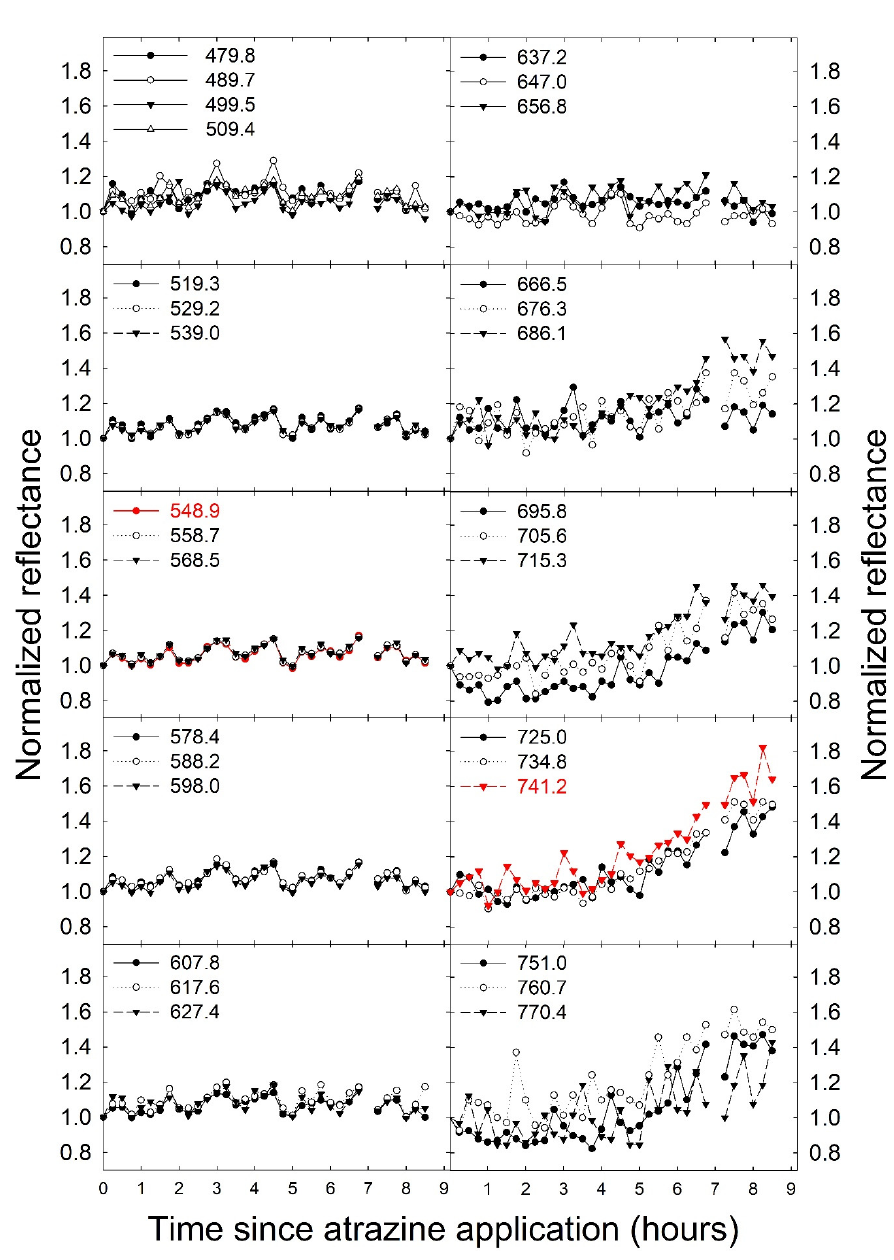
Figure 2. The normalized reflectance/fluorescence (normalized to the measured value at time 0) of Catharanthus roseus at different wavelengths as a function of the time since atrazine application. Values in the figure legends indicate the wavelength at which the reflectance/fluorescence was measured (nm). The two data sets in red indicate the wavelengths used for the development of the fluorescence-based stress index.